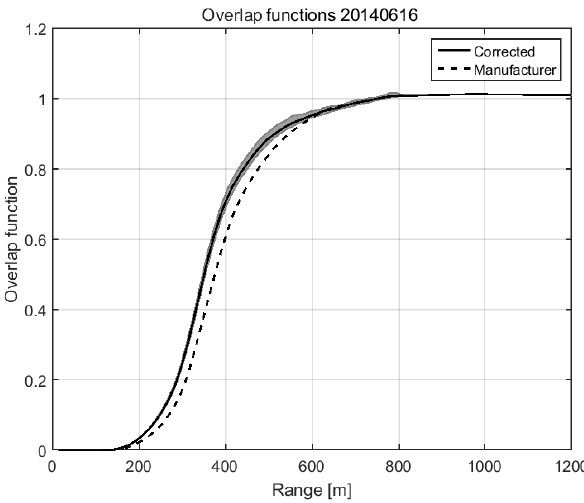
Figure 3. Overlap functions for 16 June 2014. The thick black line is the median overlap function for this day. The dashed line repre- sents the overlap function provided by the manufacturer.